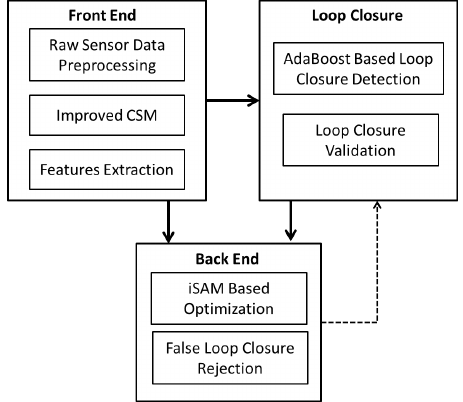
Figure 1. The overview of our 2D-SLAM